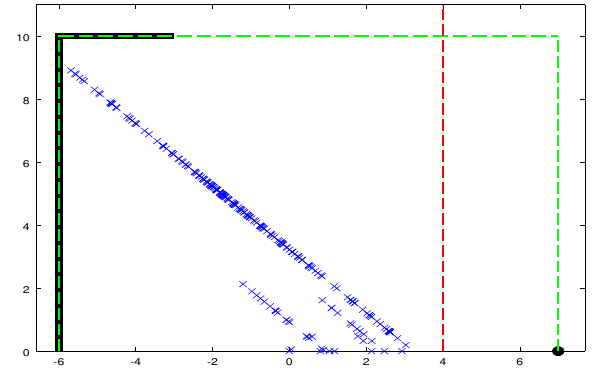
Figure 1. A sample path of ( X , Y ) with X a spectrally negative Lévy process. The region R has d = 10, a = − 6 and b = 7; the dark boundary shows the possible exit points of ( X , Y ) from R . The base of the red line separates R in two parts with different